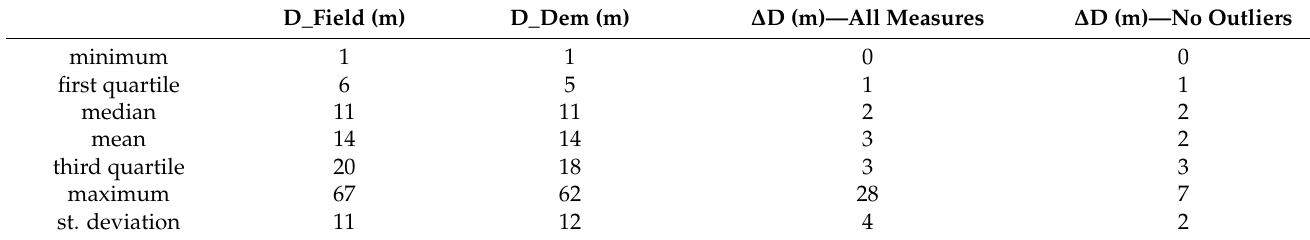
Table 5. Basic statistics of the depth (D) and depth difference ( ∆ D) of the investigated